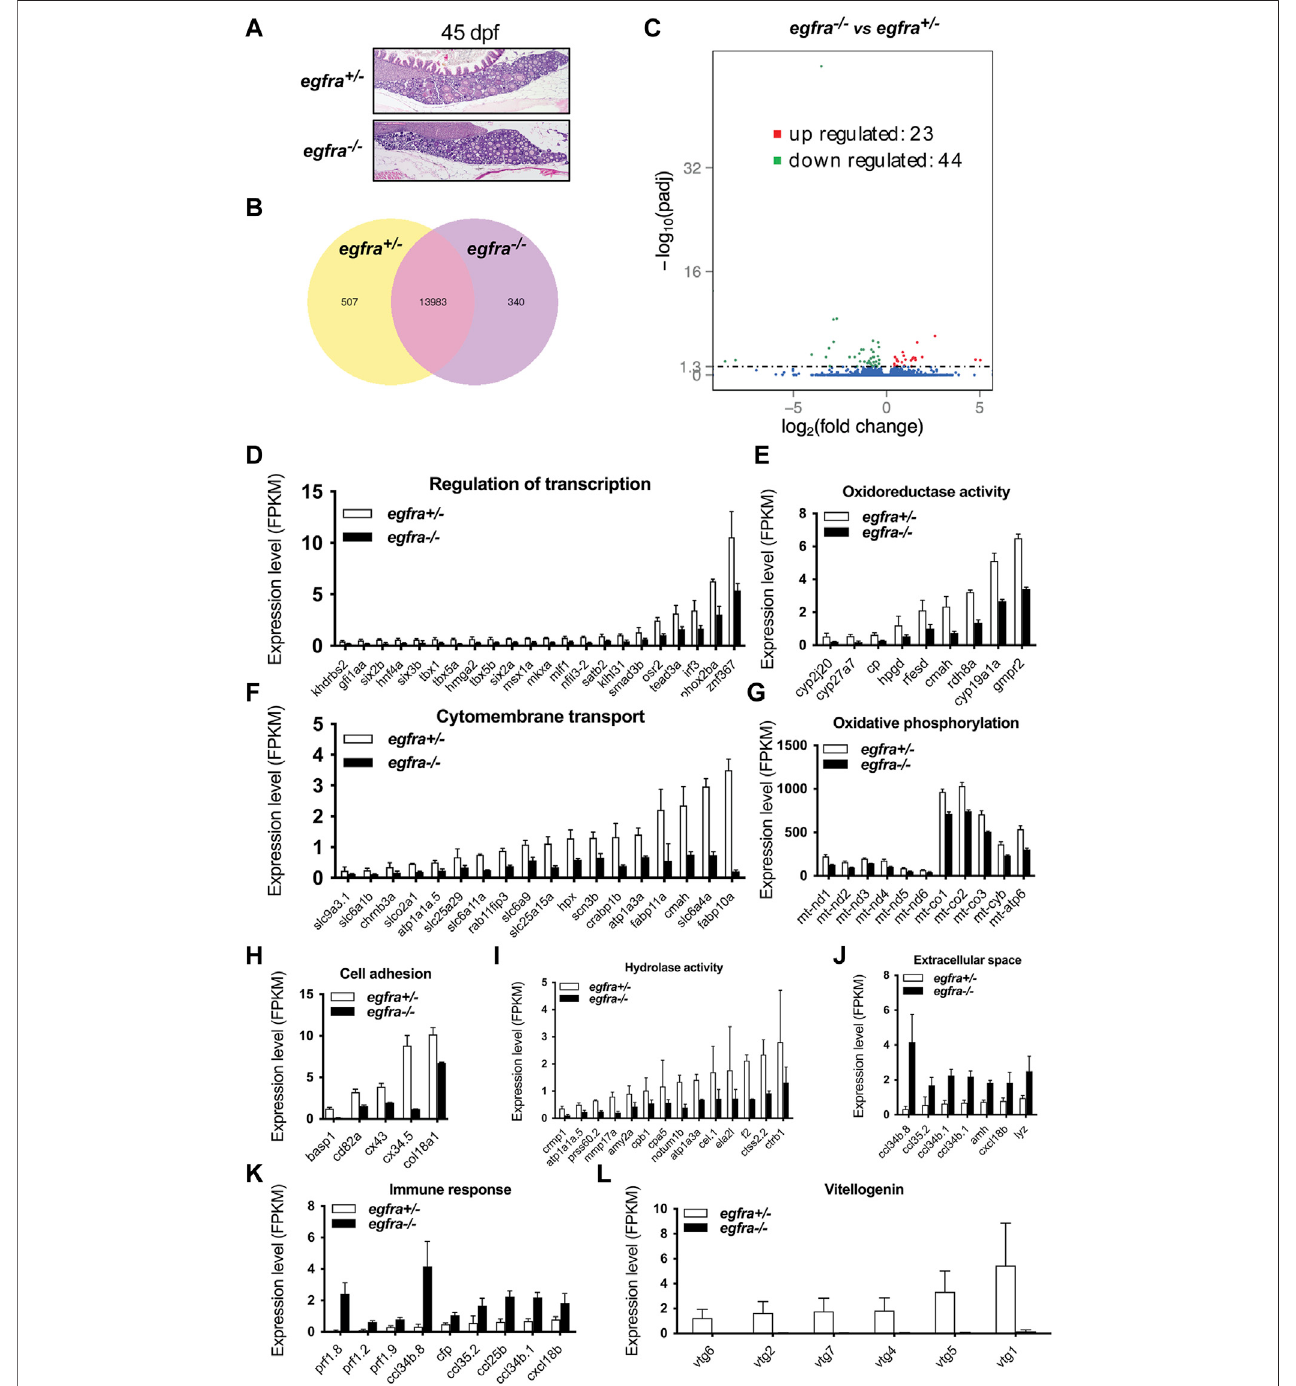
FIGURE 8| Transcriptomeanalysis for differentially expressed genes (DEG) in egfra − / − zebra fi sh ovary. (A) The ovaries ofcontrol ( egfra +/ − ) and mutant ( egfra − / − ) at 45 dpf when follicle activation or PG-PV transition occurs. (B) Venn diagram illustrating DEGs in egfra +/ − and egfra − / − ovaries. FPKM was used to normalize gene expression levels with FPKM > 1 being the expression threshold. In total, 13,983 genes were expressed in the ovaries of both egfra+/ − and egfra − / − fi sh, whereas 507 and 340 genes were only expressed in the ovaries of egfra+/ − and egfra − / − fi sh, respectively. (C) MA plot showing the signi fi cantly downregulated (in green) and upregulated (in red) genes. (D – I) Enrichment of downregulated genes in transcription regulation, oxidoreductase activity, cytomembrane transport, oxidative phosphorylation (mitochondrial metabolic pathway), cell adhesion, and hydrolase activity. (J,K) Enrichment of upregulated genes in extracellular space and immune response. (L) Loss of expression of vitellogenin genes ( vtg1 , vtg2 , vtg4 , vtg5 , vtg6 , and vtg7 ) in mutant ovary follicles ( egfra − / − ). FPKM, fragments per kilobase million.